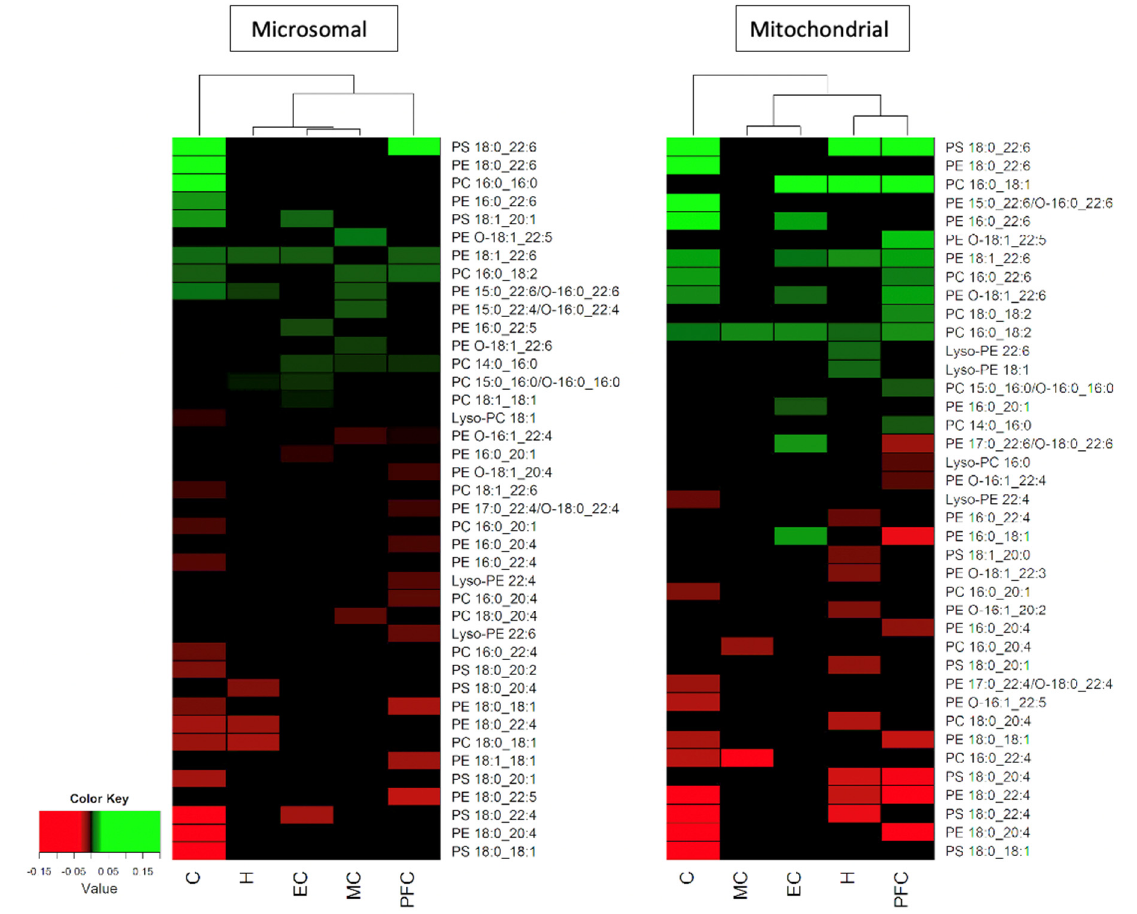
Figure 2. A summary of the significant changes seen with normal ageing in the phospholipid composition (% of the phospholipid class) in the microsomal and mitochondrial membranes of the cerebellum (C), motor cortex (MC), entorhinal cortex (EC), hippocampus (H) and prefrontal cortex (PFC). Increases in phospholipids with age are shown in green, and decreases in red. The hierarchical clustering of the five brain regions is shown by the dendrogram at the top of each heat map. Based on the hierarchical clustering of the changes in the phospholipids associated